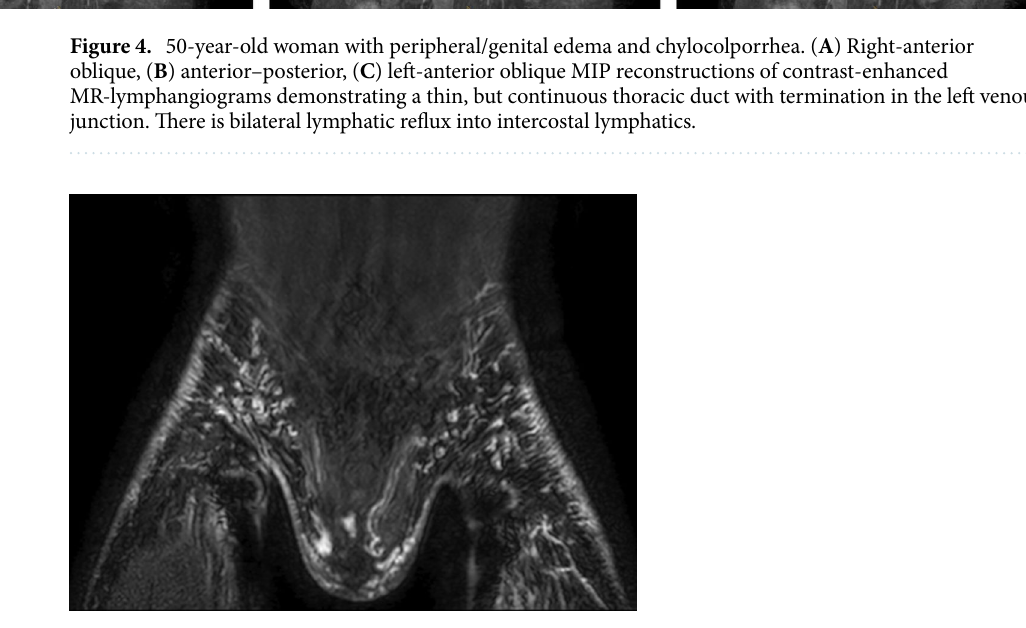
was completely or partially absent in 1/11 (9%) and 9/11 cases (82%), respectively (Fig. 2). The lower part of the TD was identified in 10/11 cases (91%). Identification of the further parts of the TD decreased with direction of contrast-agent flow (Fig. 3). Although DCMRL identified the TD-venous junction less often than T2w-imaging (3 vs. 5), DCMRL revealed the venous junction to be bilateral in two cases which was not visible on T2w-imaging (Table 3). Lymphatic reflux into intercostal lymphatics was observed in all patients (Fig. 4). Reflux into mediastinal and peribronchial lymphatics was also seen in the majority of cases (9/11 (82%) and 8/11 (73%), respectively) (Figs. 1, 2, 3). Cervical lymphatic reflux was seen in 9/11 patients (82%). Retrograde flow into peripheral and genital lymphatics was visible in 5/11 (45.5%) and 4/11 cases (36%), respectively (Fig. 5). Lymphatic collaterals in the abdominal or thoracic wall were seen in 5/11 (45.5%) and 6/11 patients (54.5%), respectively. Diaphragmatic lymph vessels and the internal mammary truncs showed enhancement in 5/11 cases (45.5%) (Fig. 6). Finally, we observed lymphatic flow from the abdomen into the thorax via paraoesophageal lymphatics in 3/11 patients (27%) (Patient No. 6, 7 and 9) (Fig. 6). Abnormal lymphatic perfusion of lung parenchyma was seen in 8/11 patients (73%) (7 bilateral, 1 unilateral) and of the pleura in 8/11 patients (73%) (5 bilateral, 3 unilateral). Peritoneal lymphatic perfusion was only seen in one patient who did not have ascites at the time.